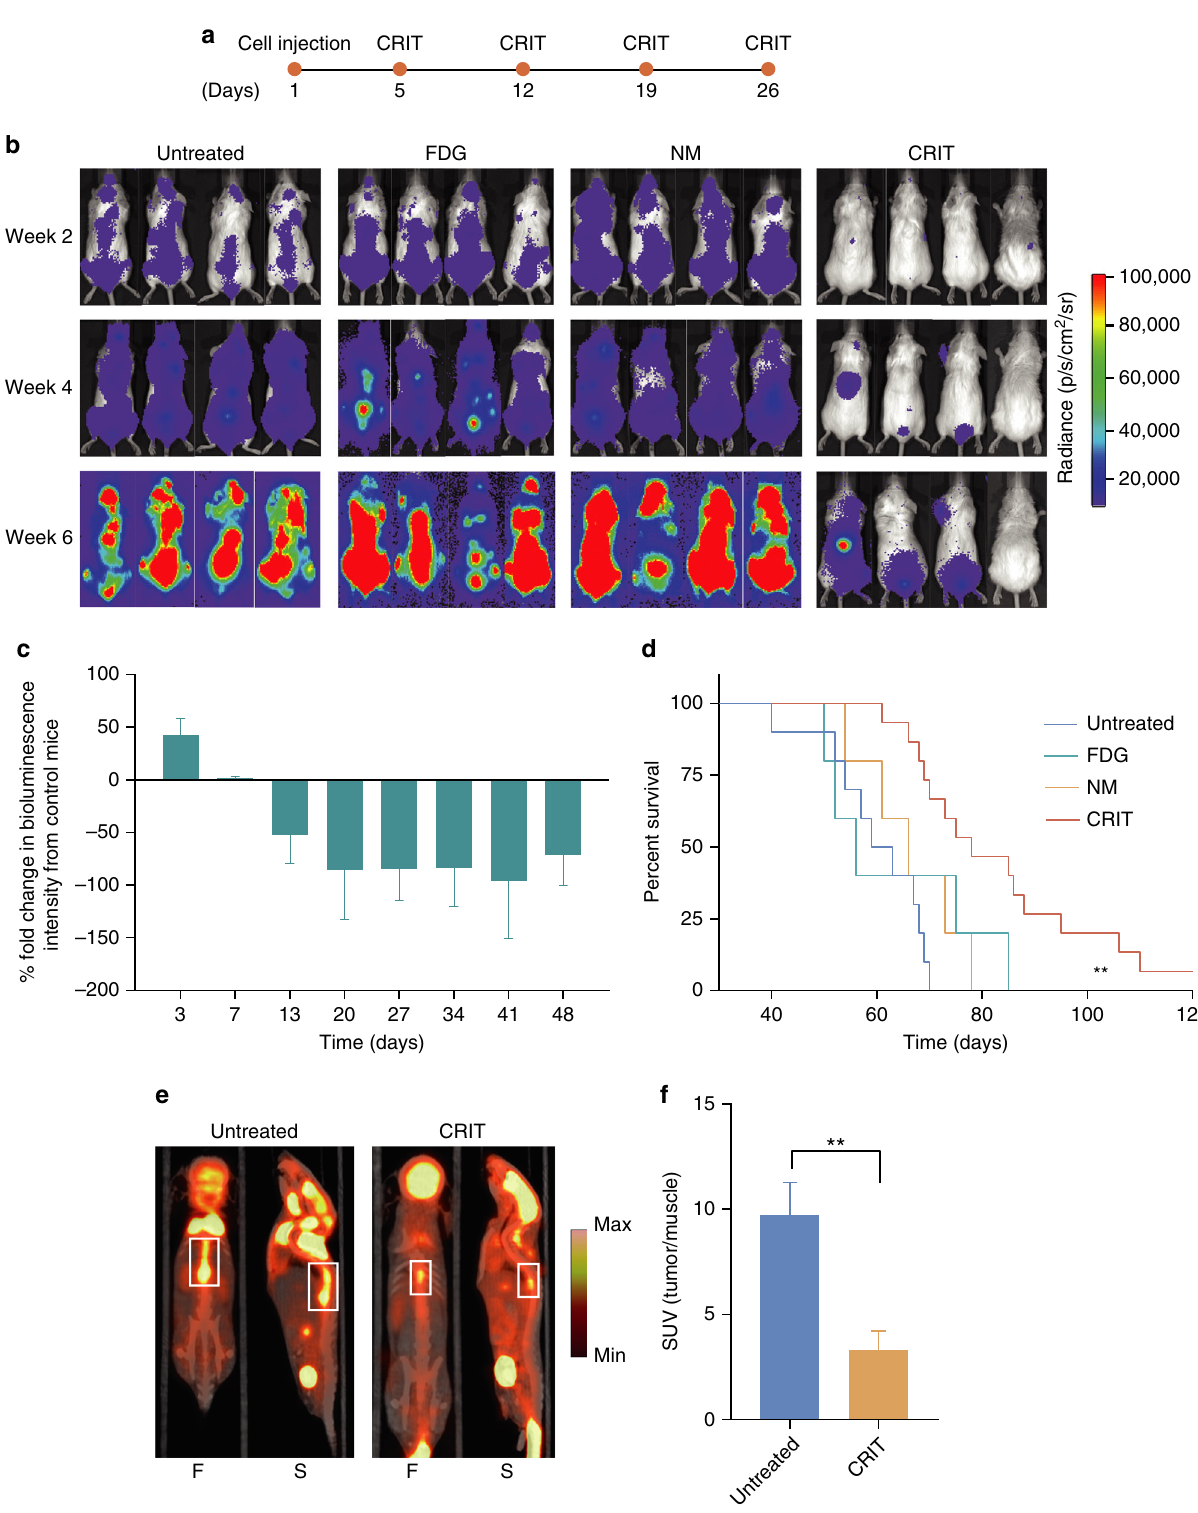
Fig. 3 Response of multiple myeloma to CRIT. a Timeline of treatment. b Bioluminescence imaging of representative multiple myeloma-bearing mice in different treatment groups — untreated, 18 FDG, NM controls and CRIT. All images are dorsal images and on the same scale. The images of control groups appear saturated on week 6 in comparison to CRIT. c Change in bioluminescence intensity as a result of treatment compared to untreated control. The intensity consistently remains lower than untreated controls during the treatment and beyond. d Comparison of survival of different treatment groups showing a twofold increase in survival in treated mice compared to control groups. ** P < 0.01. e 18 FDG-PET images of MM mice before and after treatment showing lower tumour burden in the latter. F: frontal view, S: sagittal view. Boxes denote tumour region. f SUV values of the treatment group were lower than untreated controls. ** P < 0.01. n = 15 mice for CRIT, n = 10 mice for untreated control and n = 5 mice for NM-TC alone and 18 FDG alone treated